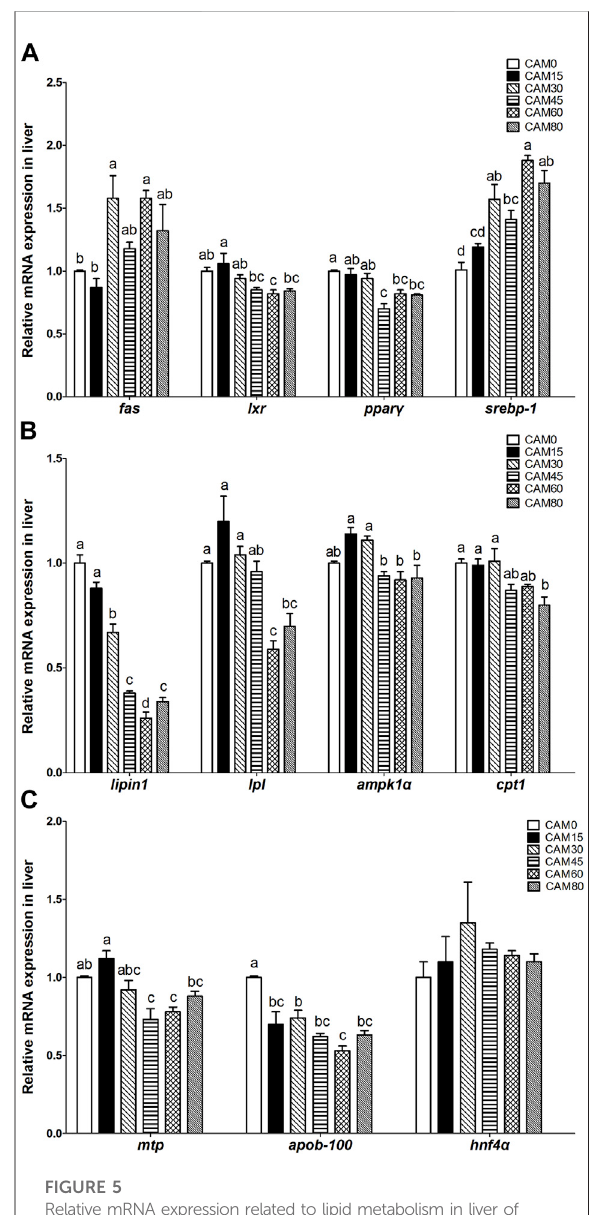
FIGURE 5 Relative mRNA expression related to lipid metabolism in liver of juvenile turbot fed different diets. lipogenesis related genes (A) ; lipid oxidation related genes (B) ; lipid transport related genes (C) . Data are presented as means ± S.E.M ( n = 3). Columns sharing the same superscript letter or absence of superscripts are not signi fi cantly